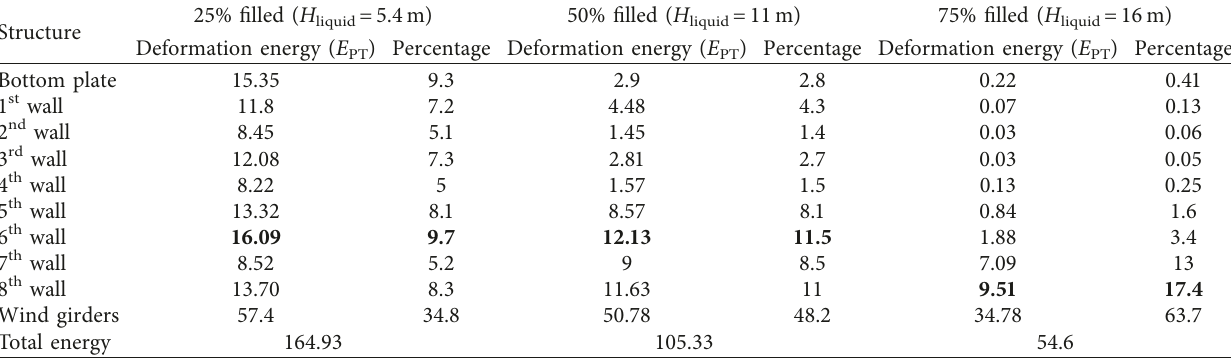
Table 5: Deformation energy of storage tank with no constraint (unit: MJ). Structure